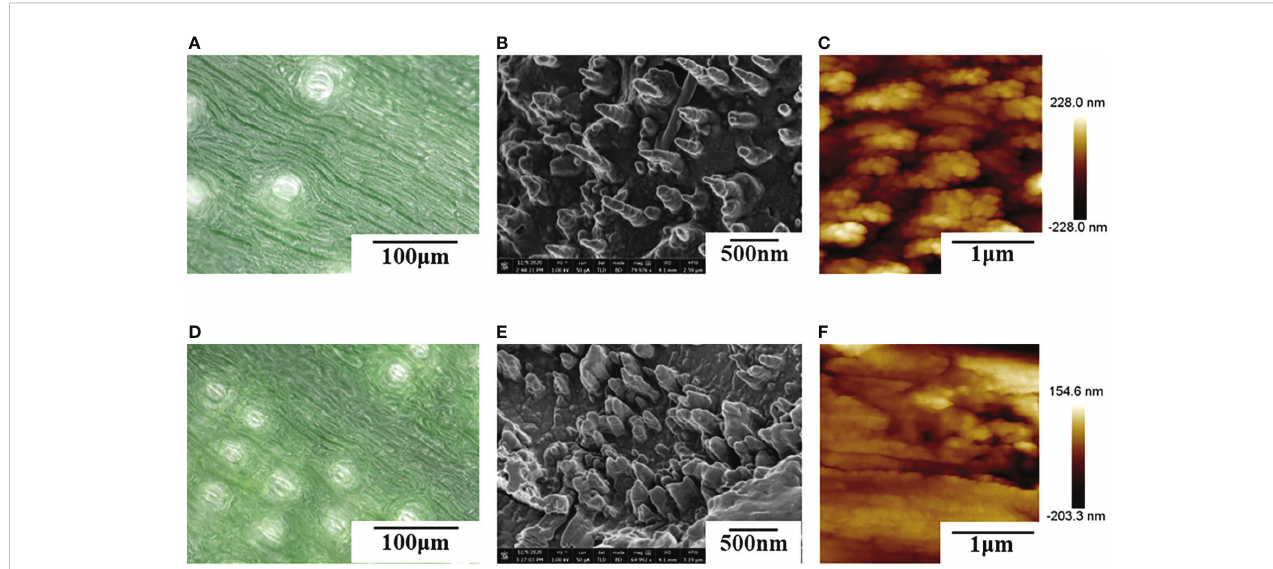
FIGURE 2 Surface microstructure of banana leaves. (A – C) : adaxial side, (D – F) : abaxial side, (A, D) : ultra-depth of fi led 3D microscope (VHX-5000) imaging, (B, E) : Field emission scanning electron microscopy (Verios 460) imaging; (C, F) : Atomic Force microscope (Dimension edge) imaging.